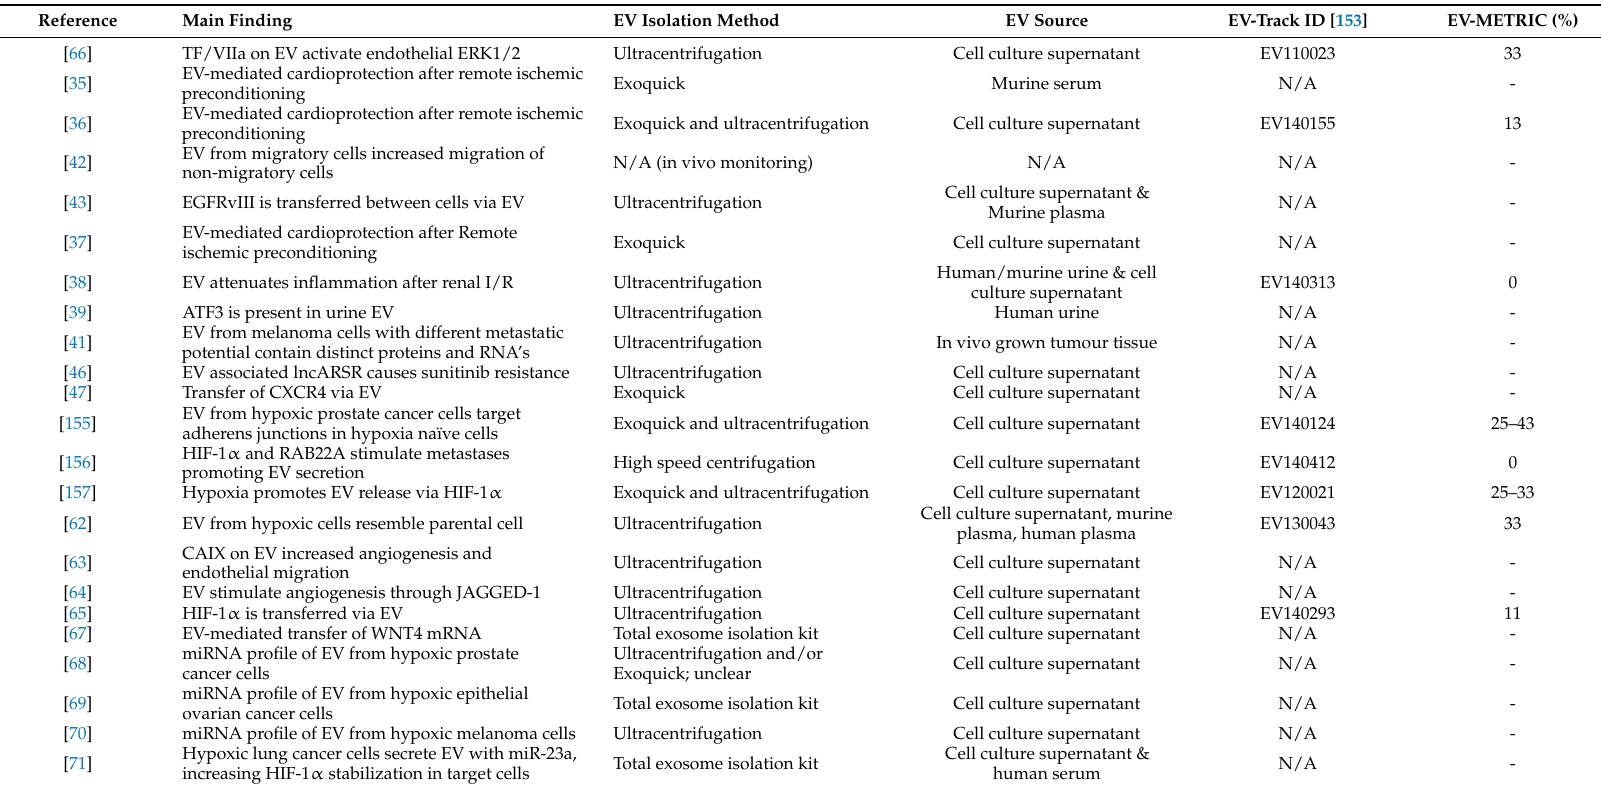
Table 2. Isolation methods and EV-METRIC scores used by the studies discussed. EV-TRACK ID as referenced in the platform for Transparant Reporting And Centralizing Knowledge in Extracellular Vesicles research (EV-TRACK [153]). EV-METRIC score represents the completeness of reporting of generic and method-specific information necessary to interpret and reproduce the experiment. N/A: Not